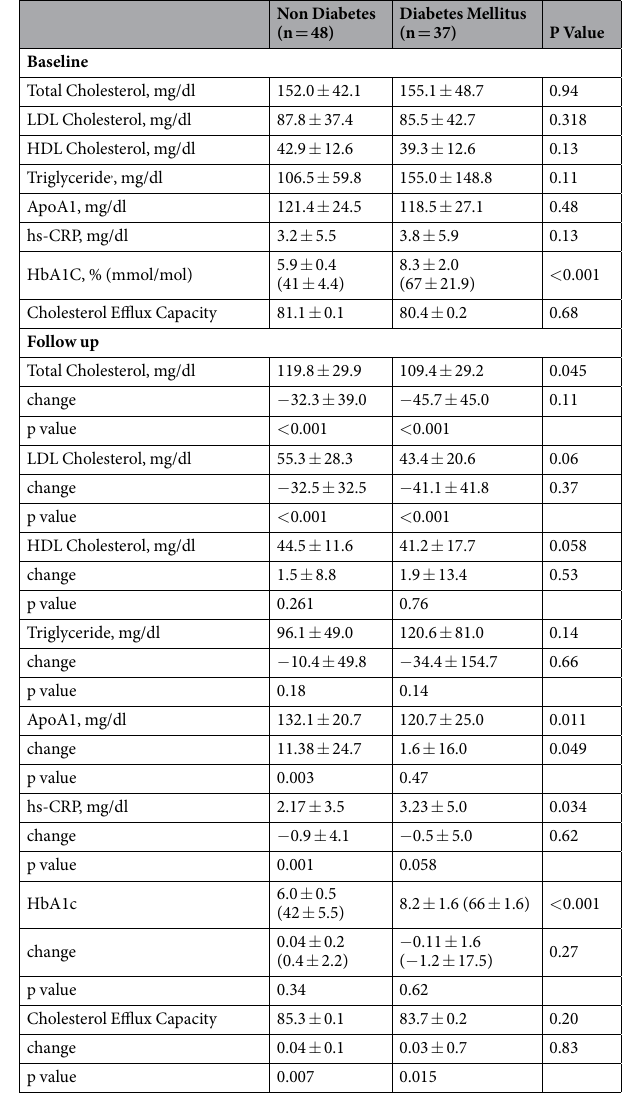
Table 2. Chemical parameters and cholesterol efflux capacity at baseline and follow up. Values are mean ±